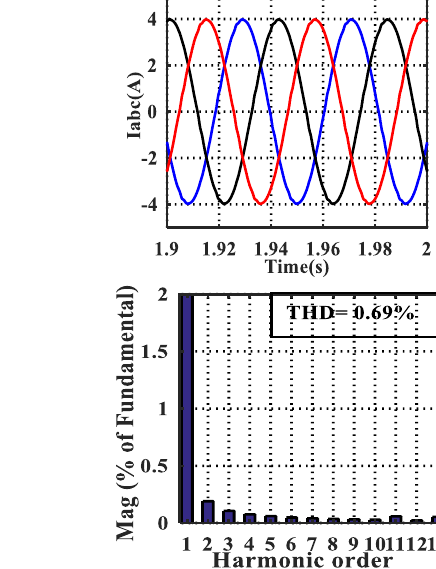
( c ) Figure 11. Simulation results of the q -axis current in the steady-state without load: ( a ) with a PI controller, ( b ) with a PIR controller and ( c ) with a Robust-TDOFR controller.